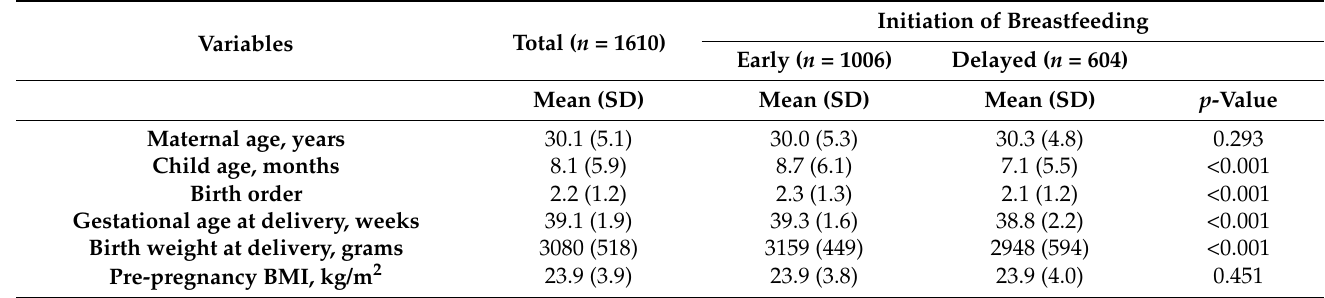
Table 1. Mean (S.D.) of the sociodemographic characteristics of the participants ( n = 1610) using t -test.